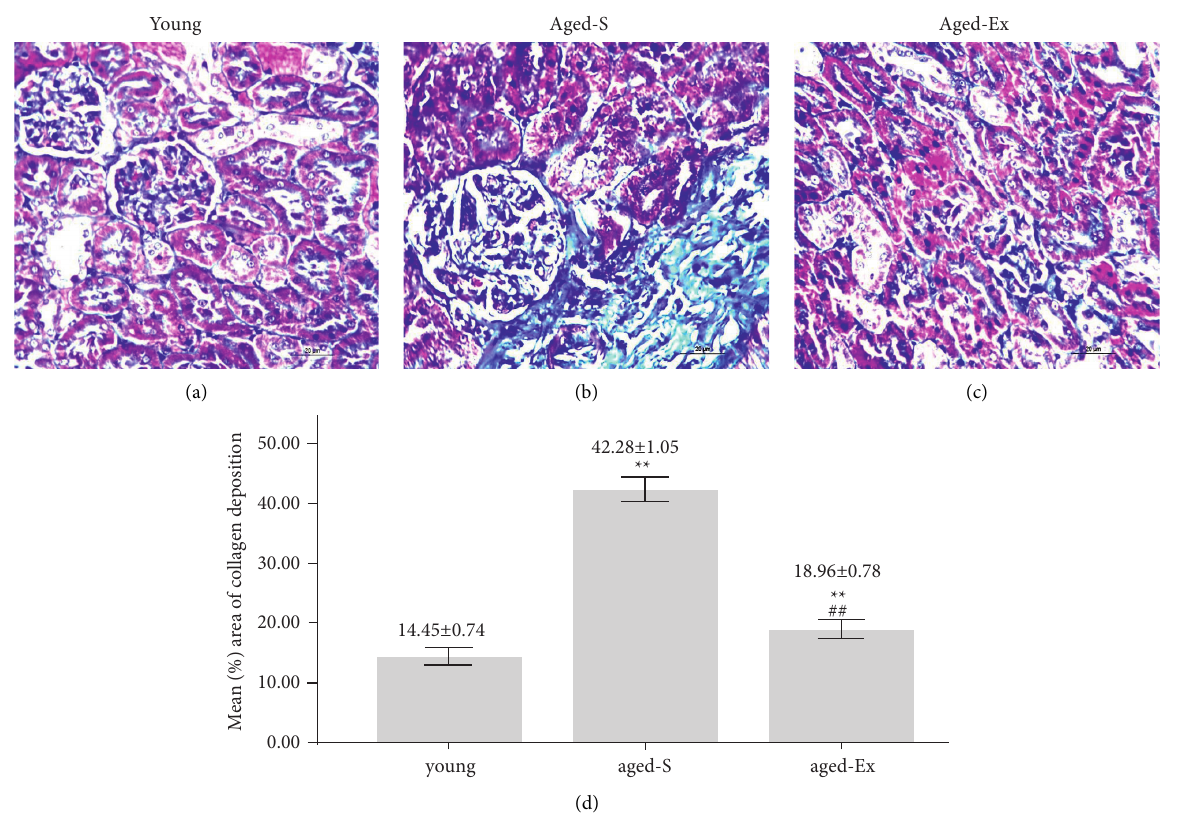
Figure 7: (a–c) Representative micrographs of Mallory’s trichrome-stained renal sections of the different studied groups ( N � 10/group) showing marked fibrosis in the sedentary aged group (aged-S) compared with the control. It is evident that the renal fibrosis is decreased with exercise (40x, scale bar � 20 µ m). N � number of rats. (d) A histogram denoting the mean % area of collagen deposition in the young, aged-S, and exercised aged (aged-Ex) groups. ∗∗ indicates P < 0 . 001 compared with the young group; ## indicates P < 0 . 001 compared with the aged-S group. The data expressed as mean ±